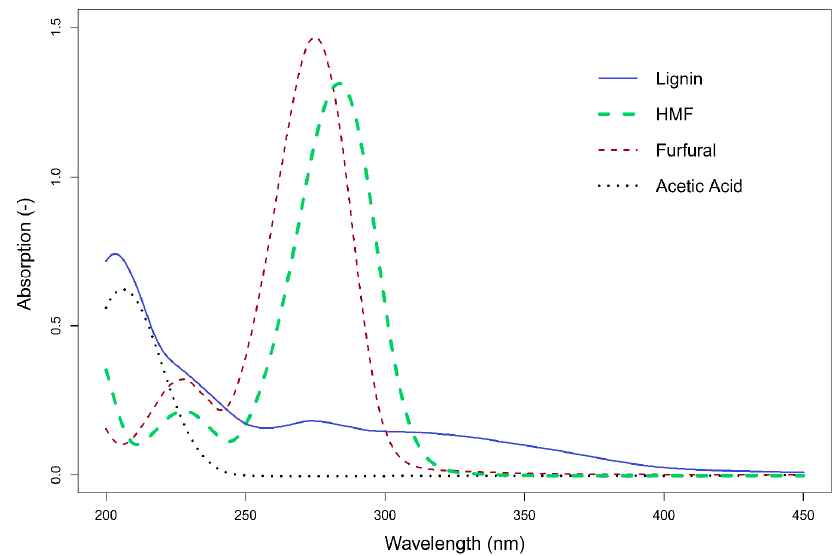
Figure 2. UV-Vis spectra of the pure components measured in 60 wt % aqueous ethanol. Spectra of